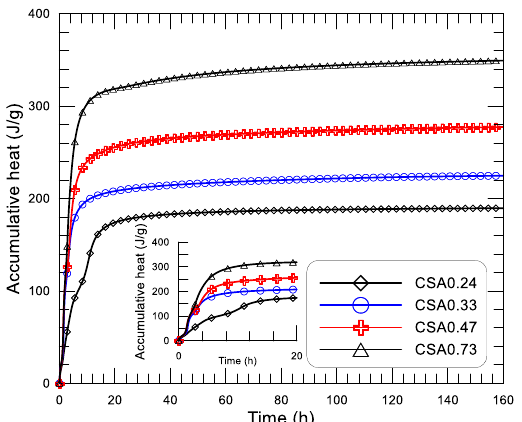
Figure 10. Accumulative heat-age diagrams of CSA pastes with different of w/c.